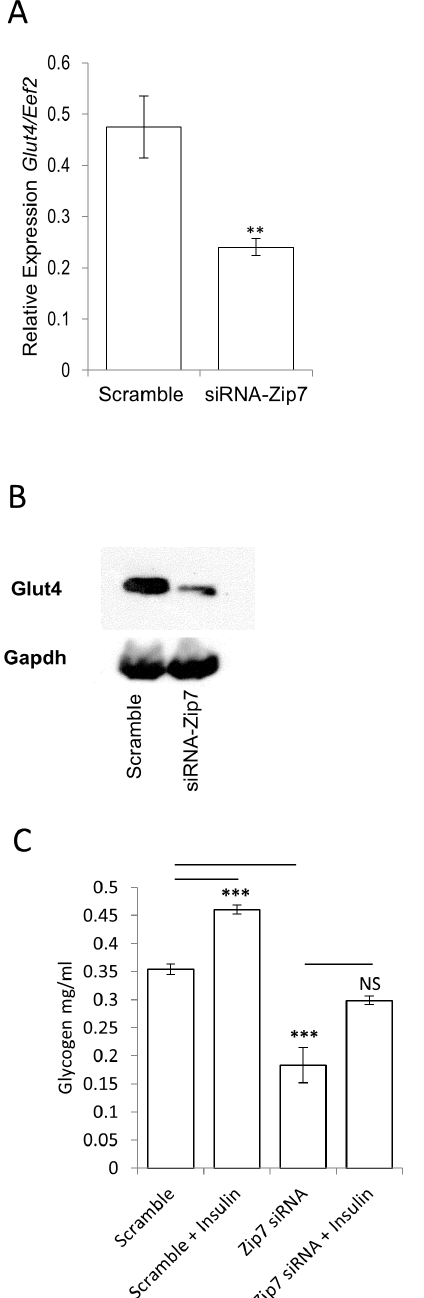
Figure 6. Reduced Zip7 expression reduces the expression of Glut4 and decreases glycogen synthesis. A). Relative expression of Glut4 mRNA to Eef2 in the scramble control and siRNA- Zip7 C2C12 cells. B). Western blot for immunoreactive Glut4 and Gapdh in protein lysates from the scramble control and the siRNA- Zip7 C2C12 cells. C). Assay for glycogen synthesis in scramble and siRNA- Zip7 cells treated with 10 nM insulin for 1 hour. D). Error bars indicated the 6 SD from three independent biological samples for Glut4 mRNA, and six independent transient transfections of the siRNA- Zip7 for the glycogen synthesis. ** P , 0.01, *** P , 0.001.